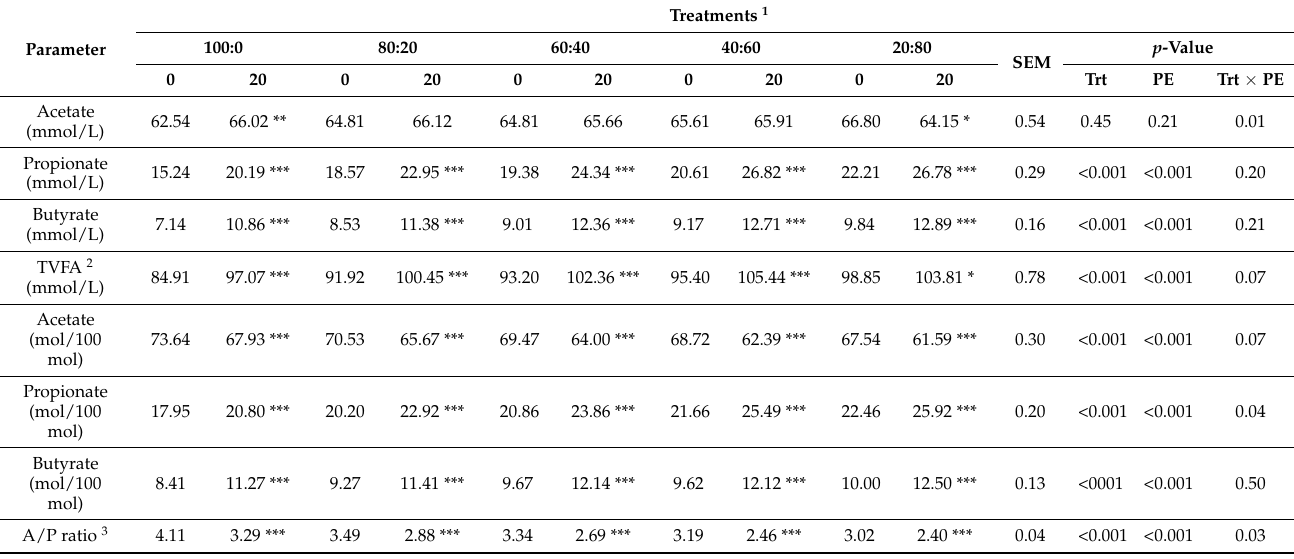
effect ( p > 0.05, Table 5). The concentration and the ratio of propionate and butyrate increased ( p < 0.001) by adding PE in all feeding models. Additionally, the concentration of total volatile fatty acids (TVFA) showed the same finding (Table 5). The acetate/propionate (A/P) ratio decreased ( p < 0.001) with PE supplementation in all feeding styles (Table 5). Table 5. Effect of plant-bioactives extract (PE) supplementation on volatile fatty acids in different feeding styles after 24 h In Vitro incubation ( n =